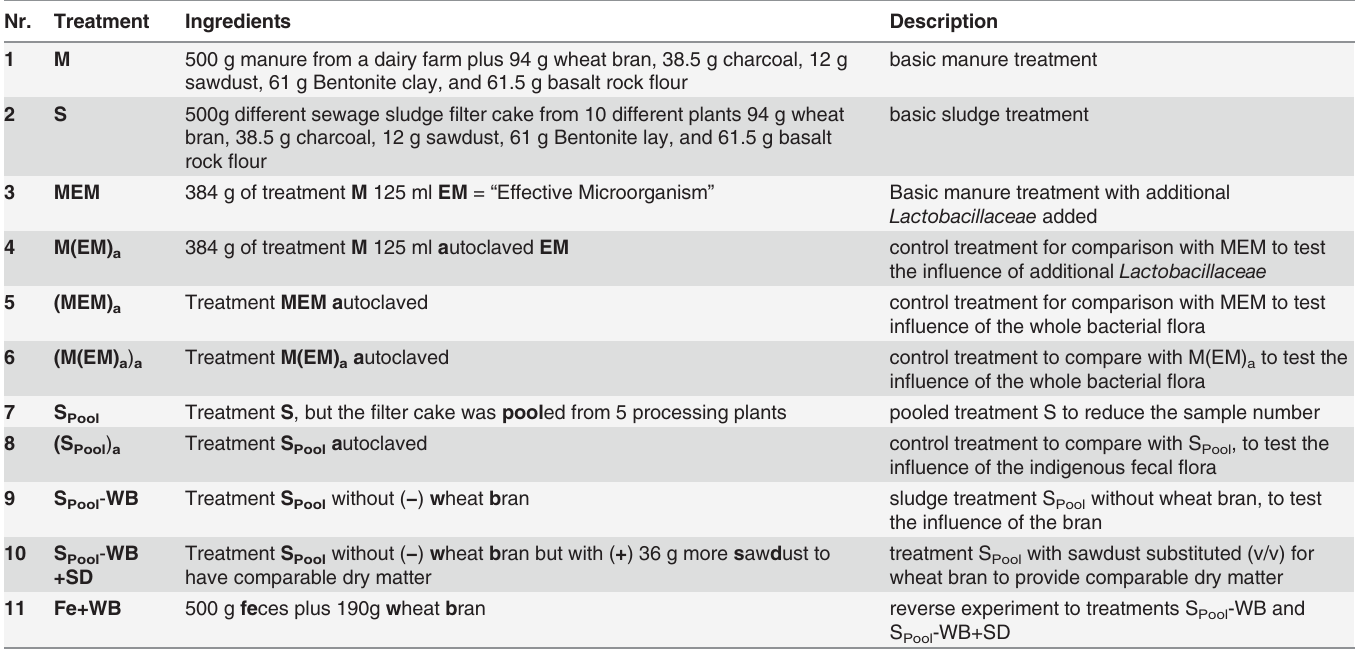
Table 1. Composition of treatments 1 to